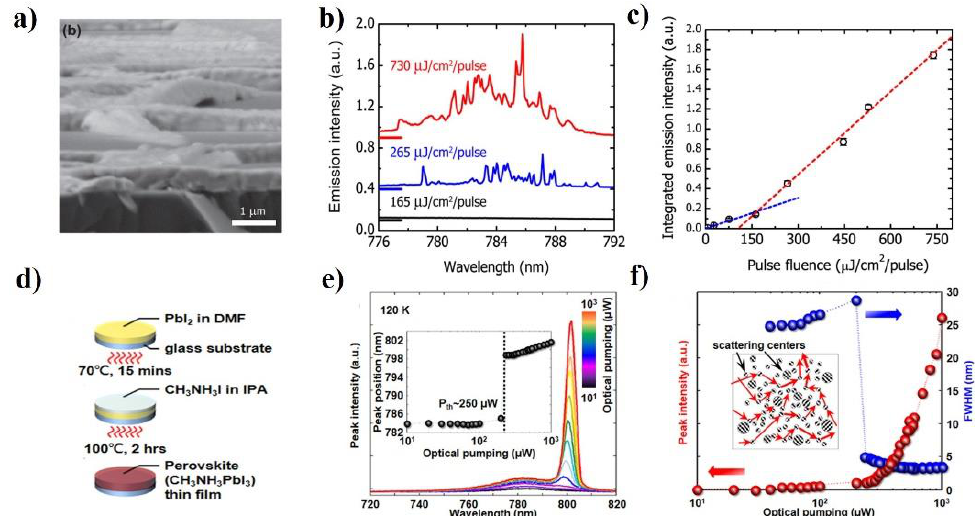
Figure 3. ( a ) Cross-sectional SEM image of the perovskite network. ( b ) Emission spectra are collected below, near, and above the lasing threshold. ( c ) Integrated emission intensity as a function of excitation pulse fluence. The lasing threshold is 195 ±30 μJ/cm 2 /pulse. The images ( a – c ) were adapted with permission from Ref. [60]. Copyright 2014 AIP Publishing LLC. ( d ) Schematic diagram of the perovskite MAPbI 3 films prepared in solution processes. ( e ) PL emission spectra of the fabricated perovskite films, photo-excited at different optical-pumping powers. ( f ) L-L curve plotted on a log-linear scale and the corresponding linewidths as a function of pumping powers. The images ( d – f ) were adapted with permission from Ref. [96]. Copyright 2014 AIP Publishing LLC.